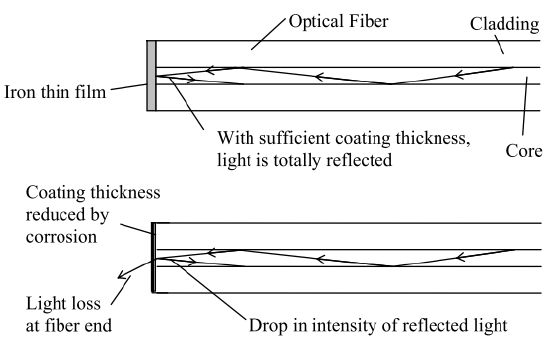
Figure 9. Point optical fiber sensor for corrosion monitoring based on reflected light from the Fe thin film coating [52].